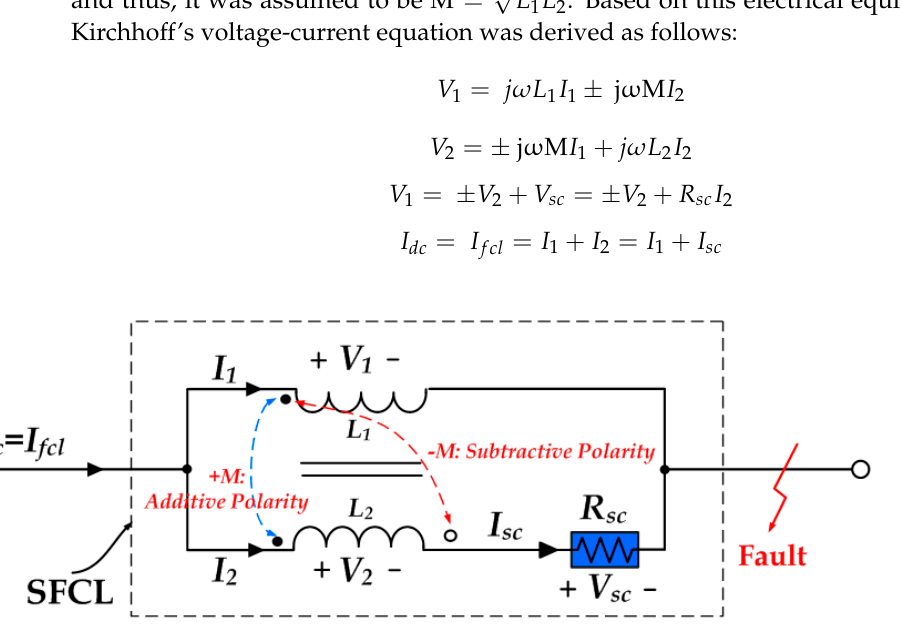
Figure 3. Electrical equivalent circuit of the SFCL using two parallel flux-coupled coils.